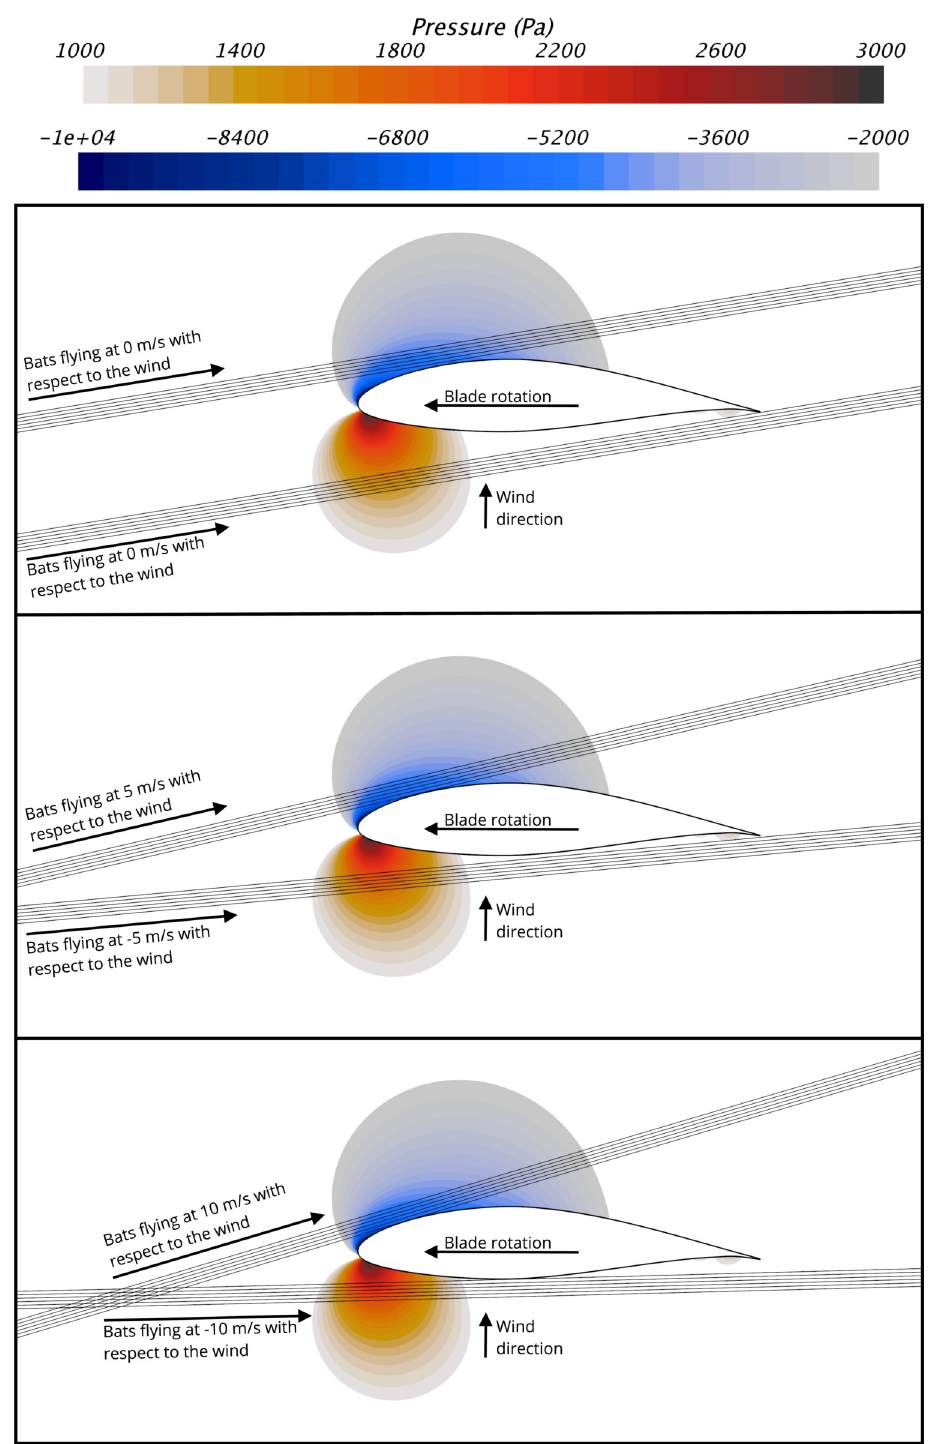
Fig 7. Bat flight paths by the 90% blade span location of the NREL 5 MW wind turbine operating at a wind speed of 10 m/s. (Top) Flight paths for bats flying at 0 m/s with respect to the wind. (Middle) Flight paths for bats flying at ± 5 m/s, with respect to the wind. (Bottom) Flight paths for bats flying at ± 10 m/s, with respect to the wind. The pressure contours show the pressure variations caused by the blade that are below -2000 Pa and above 1000 Pa, with respect to atmospheric pressure. For scale, note that the bat flight paths are separated by 20 mm in the direction normal to the flight paths.